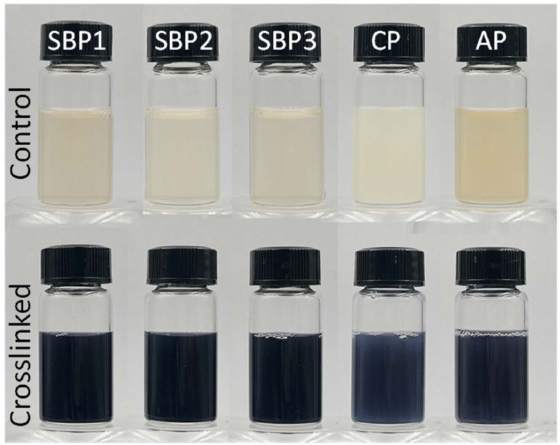
Figure 1. The visual appearance of pectin solution (1 wt%) before ( up ) and after ( down ) genipin crosslinking reaction.